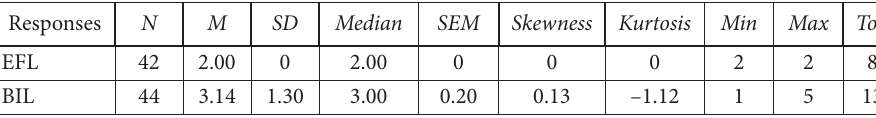
Table 5. Descriptive statistics of the scale items E – care, attention to detail, etc . for English as foreign language (EFL) and bilingual (BIL) groups (source: created by